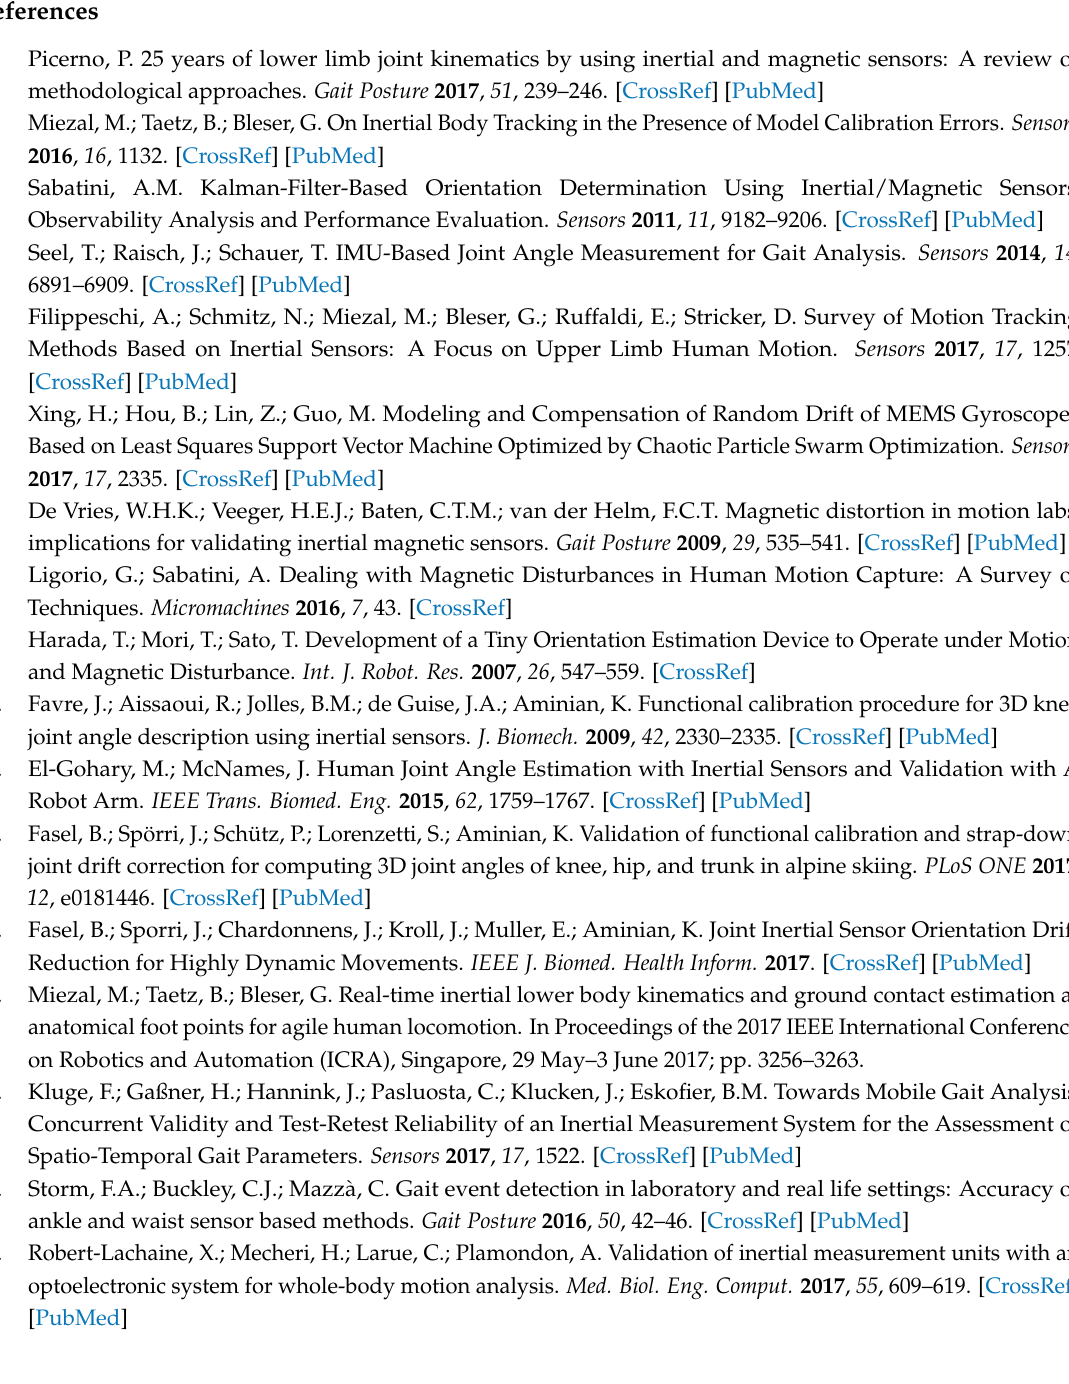
Figure A7. BA diagrams of 3D joint rotations of the pelvis for condition 2. The solid line indicates the mean difference. The dashed lines indicate the LoA (95% CI) of the mean difference.